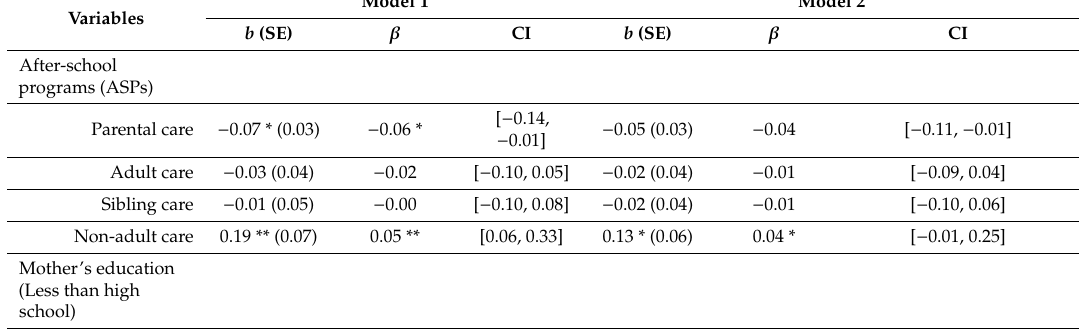
Table 3. OLS regression estimates on emotional-behavioral